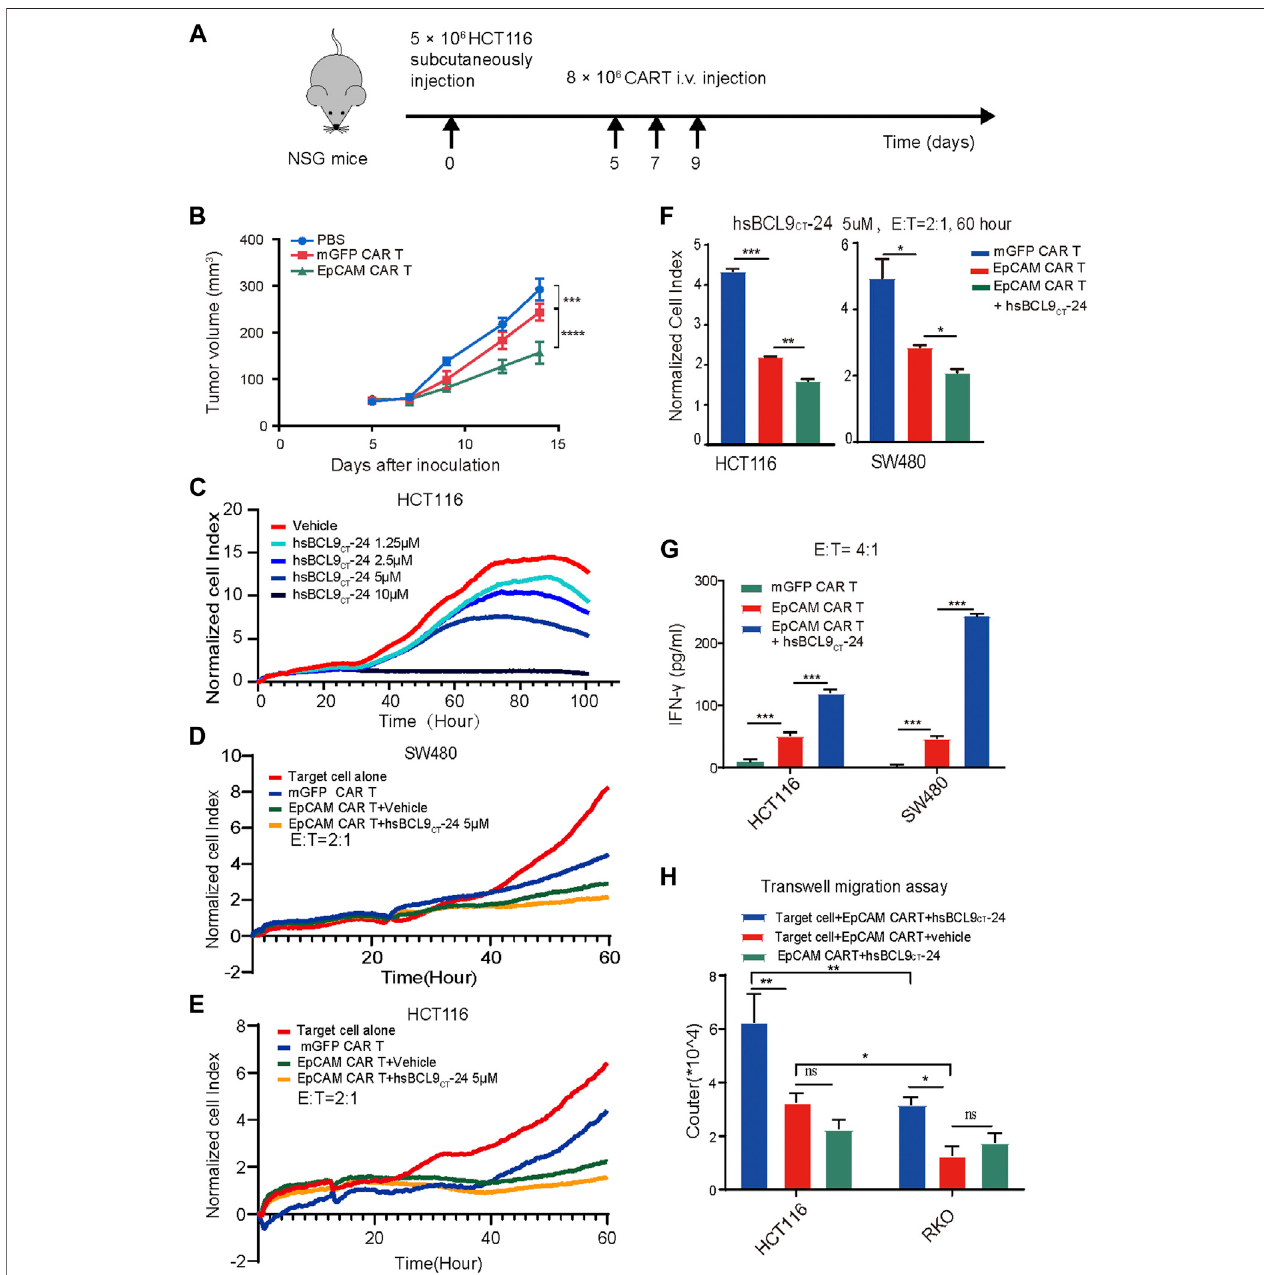
FIGURE 5 | The speci fi c tumor killing effect of EpCAM CAR T cells in HCT116 mouse model and synergetic activity of EpCAM CAR T and hsBCL9 CT -24 in vitro . A total of 5 × 10 6 HCT116 cells were subcutaneously injected into NSG mice on day 0 then randomized on day 5 and treated as following: untreated (PBS), mGFP CAR TcellsandEpCAMCARTcells(8 × 10 6 cells,byi.v.everyotherdayfor3times). (A) Schematicdiagramshowingthe invivo experiment.Thetumorgrowthcurvesduring theexperiment. (C) EffectofhsBCL9 CT -24aloneoncolorectalcancercellwasanalyzedbydose-dependentRTCA,performedasabove.Herewasaddingdifferent concentration of hsBCL9 CT -24, 1.25 µM, 2.5 µM, 5 µM, 10 µM instead of adding T cells. Synergetic activity of hsBCL9 CT -24 with EpCAM CAR T on the colorectal cancercellsSW480 (D) orHCT116 (E) wasdetectedbyRTCA,performedasabove,buttheadditionwasmGFPCART,EpCAMCART,EpCAMCART+hsBCL9 CT -24 atE:Tratioof2:1andhsBCL9 CT -24atconcentrationof5 µM,induplicate. (F) ThequantitativeanalysisofRTCAforsynergeticactivityofhsBCL9 CT -24withEpCAMCAR TonSW480andHCt116atE:Tratioof2:1andtimeof60 h (G) ThereleaseofcytokinewasanalyzedbyELISA.TheCAR-Tcellswereco-culturedwithtargetcellsatE:T ratio of 4:1 for 48 h treated with vehicle or hsBCL9 CT -24 (5 µM) and then the released IFN - γ in the supernatant were detected by ELISA. (H) Effect of hsBCL9 CT -24 on migrationofEpCAMCAR-Tcellswasanalyzedbytranswellmigrationassay.CAR-TcellswereseededintheupperchambersandcoculturedwithHCT116orRKOcells seeded in the lower chambers pretreated with or without hsBCL9 CT -24 (5 µM). After 24 h of co-culture, the number of the CAR-T cells that had migrated into the lower chamberwascounted.Resultsareshownasmeans ± SEMforexperimentsperformedinduplicateatleast,andthestatisticalsigni fi canceofdifferencesbetweengroups was determined by the unpaired Student ’ s t test. * p < 0.05; ** p < 0.01, *** p < 0.001.